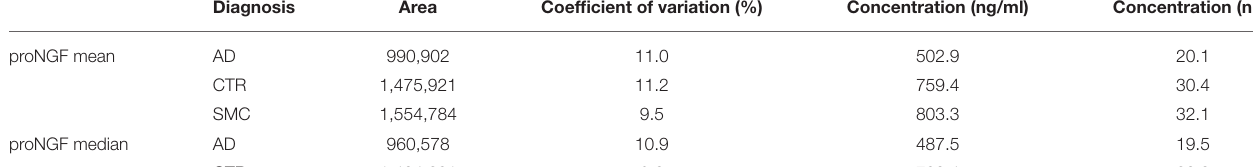
TABLE 2 | Mean and median of proNGF peaks area and proNGF concentration for the three diagnostic groups. Diagnosis Area